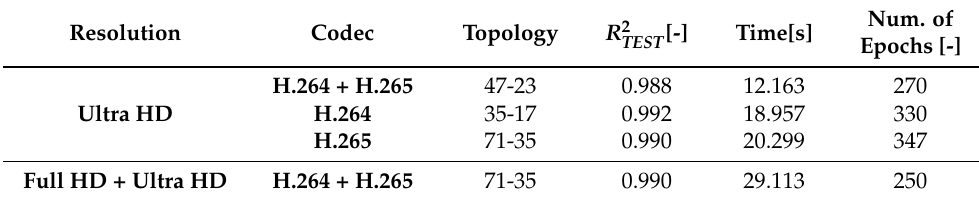
Table 8. The best topologies of bitrate prediction based on MOS. Resolution Codec Topology